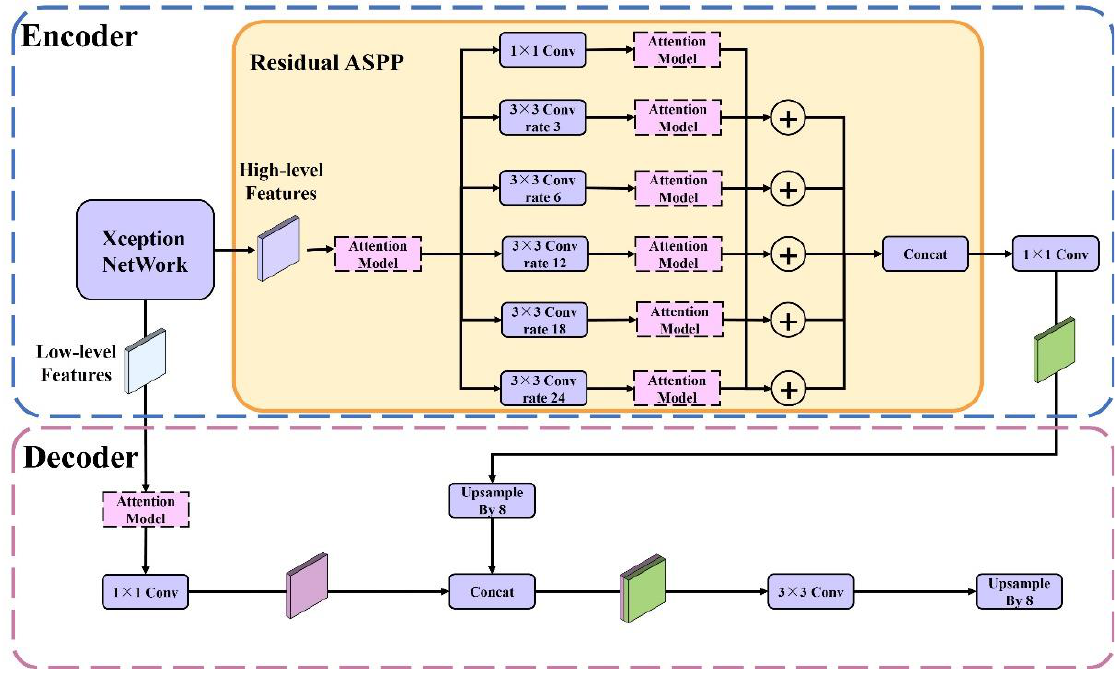
Figure 3. Structure of the